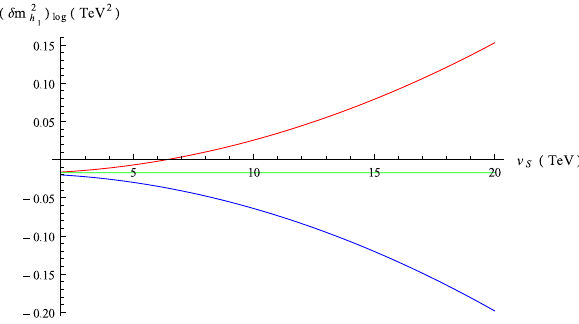
Fig. 4 Corrections to the Higgs mass as a function of υ S for λ HS = − 0 . 01 (red), λ